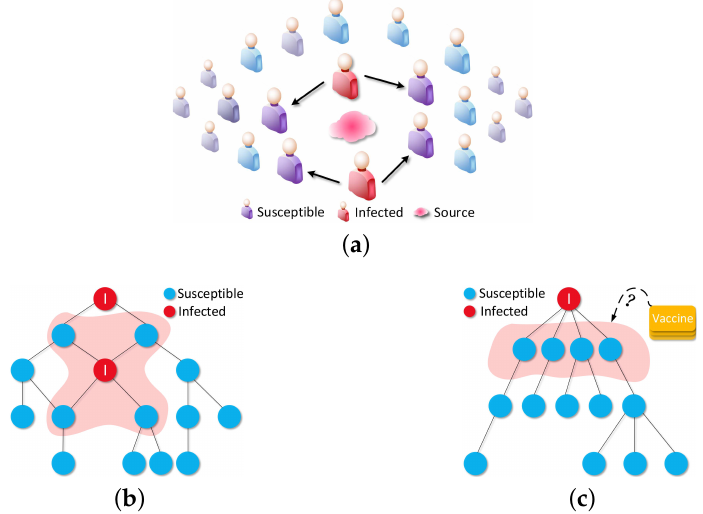
Figure 4. Fundamental Knowledge of Our Method: At first, some miserable people had caught a malignant virus and it would be spread to more and more people who have connection with those infected men; Then, we translated the abstract of social network into graph G ( V , E ) for designing an appropriate method to control the malignant virus; At last, we convert G ( V , E ) into DT by combing the infected nodes as one super infected node and let that super infected node to be the root of DT